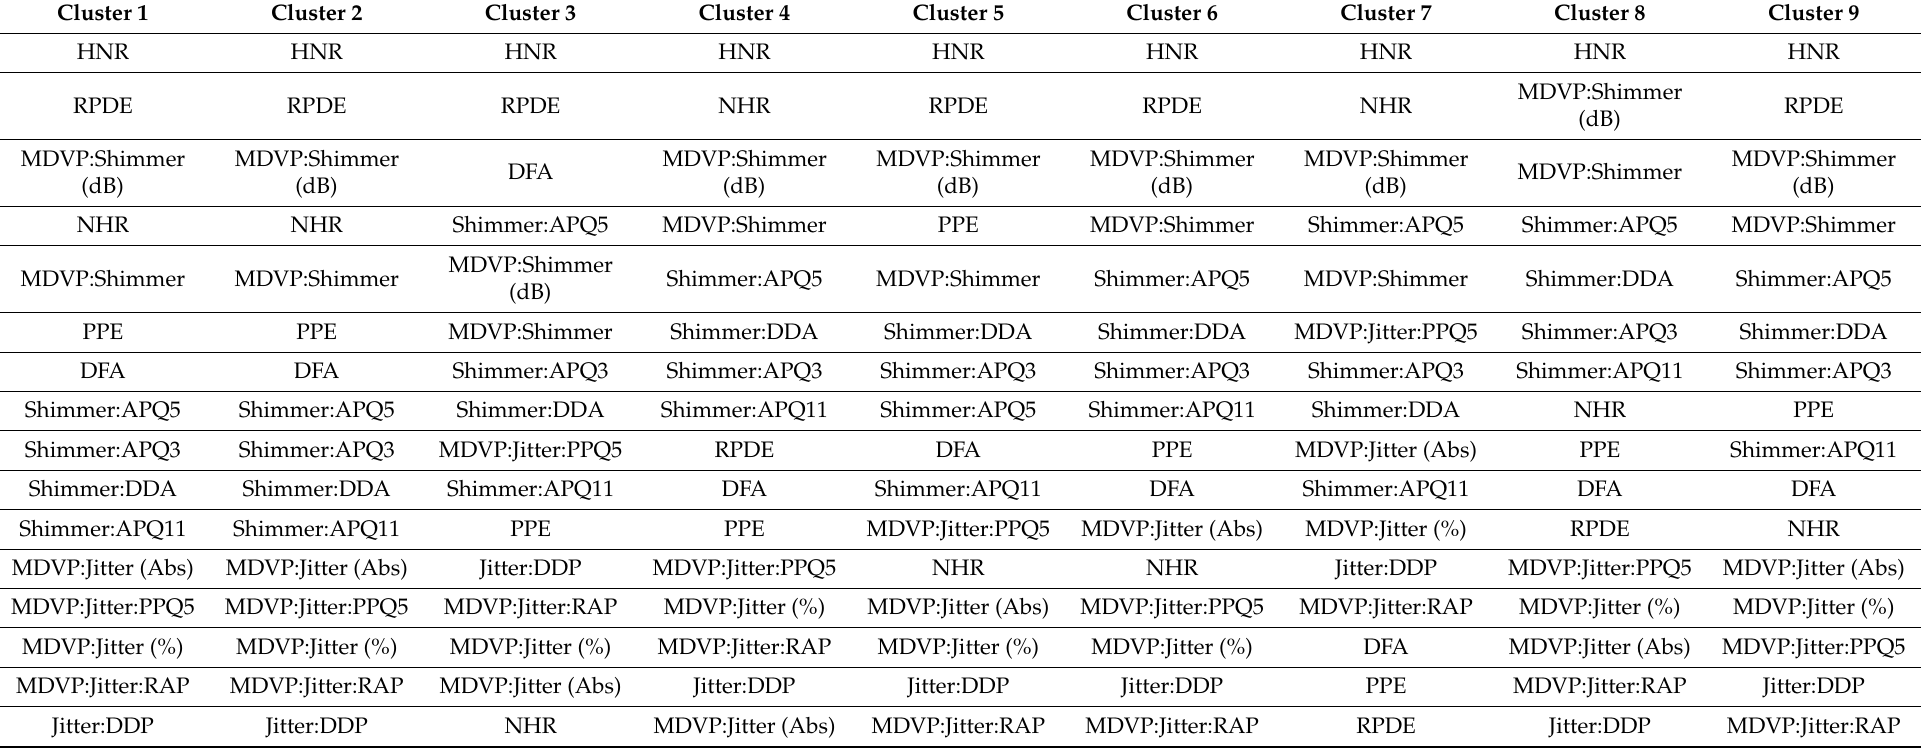
Table A1. The results for Laplacian